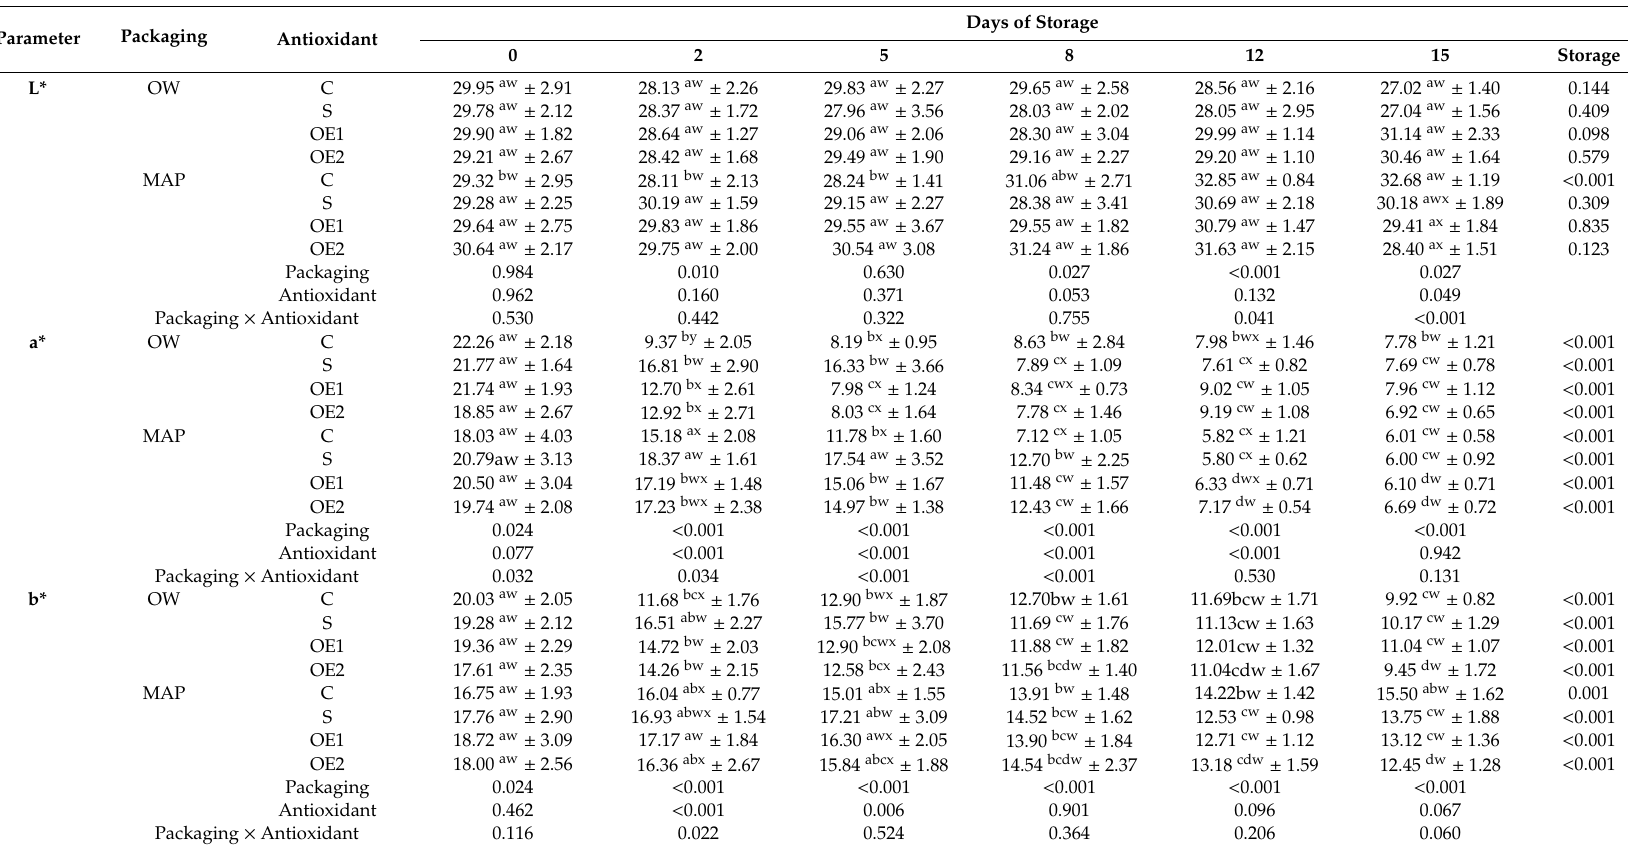
Table 3. Evolution of the color parameters (mean values ± standard deviations) of beef patties with di ff erent formulations α packed under di ff erent conditions β during storage at 4 ◦